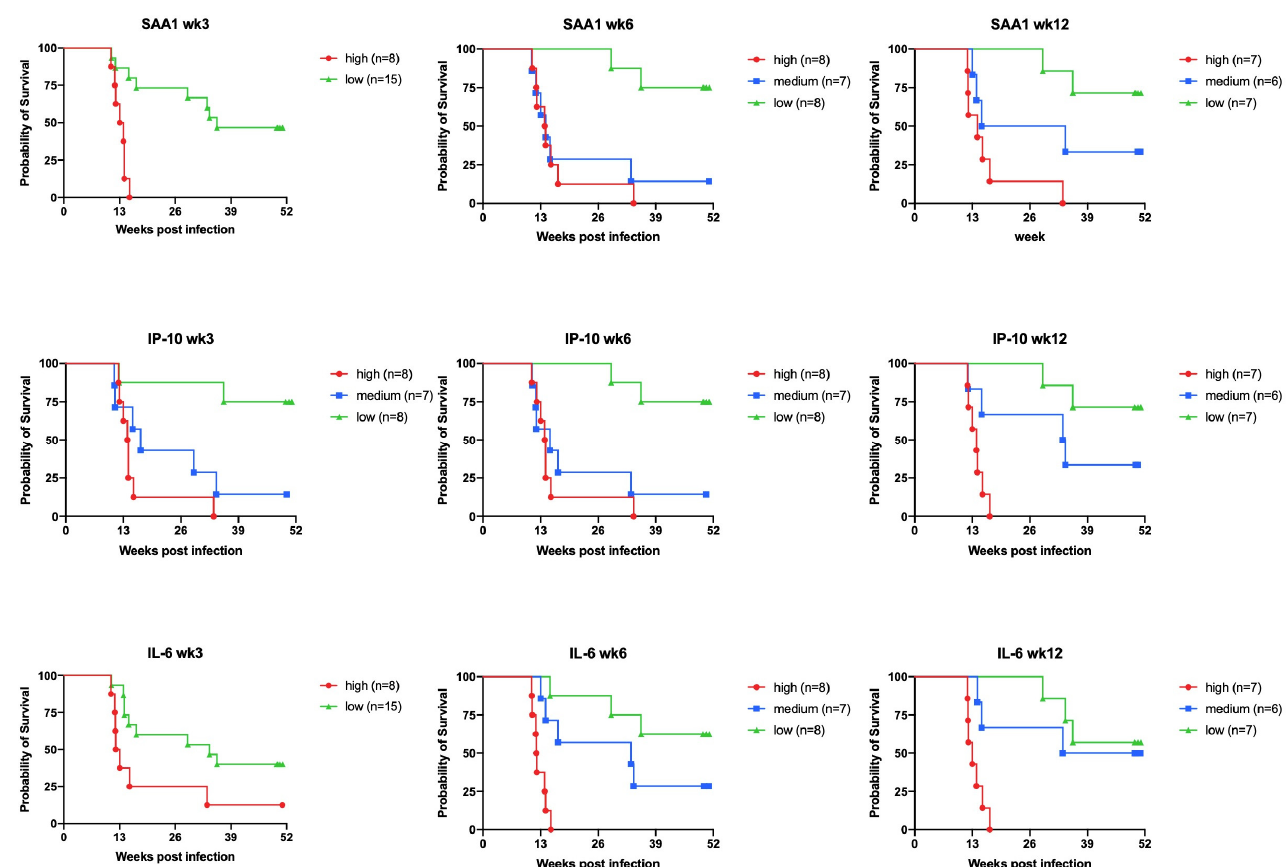
Figure 6. Correlation between SAA1, IP-10, and IL-6 levels in serum and disease severity. SAA1, IP-10, and IL-6 levels were measured by UCP-LFA in serum from high-dose (500 CFU) MTB Erdman infected rhesus macaques ( n = 23). (Since three rhesus macaques reached a humane endpoint before week 12, only 20 instead of 23 measurements are depicted at week12). The animals were sorted according to the protein levels at each time point. The top 33% of the value is defined as high responders, the middle 33% is defined as medium responders, and the last 33% is defined as low responders. All animals with undetectable protein levels are defined as low responders. Kaplan–Meier curves were plotted of individual endpoints for the high vs. the medium vs. the low responders after MTB infection. High responders after MTB infection arrive at HE earlier than medium or low responders.